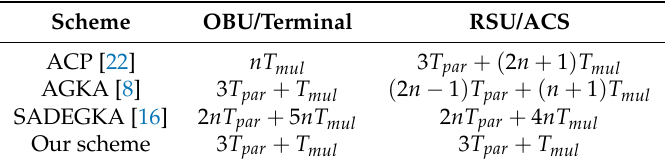
Table 2. Computation Overhead